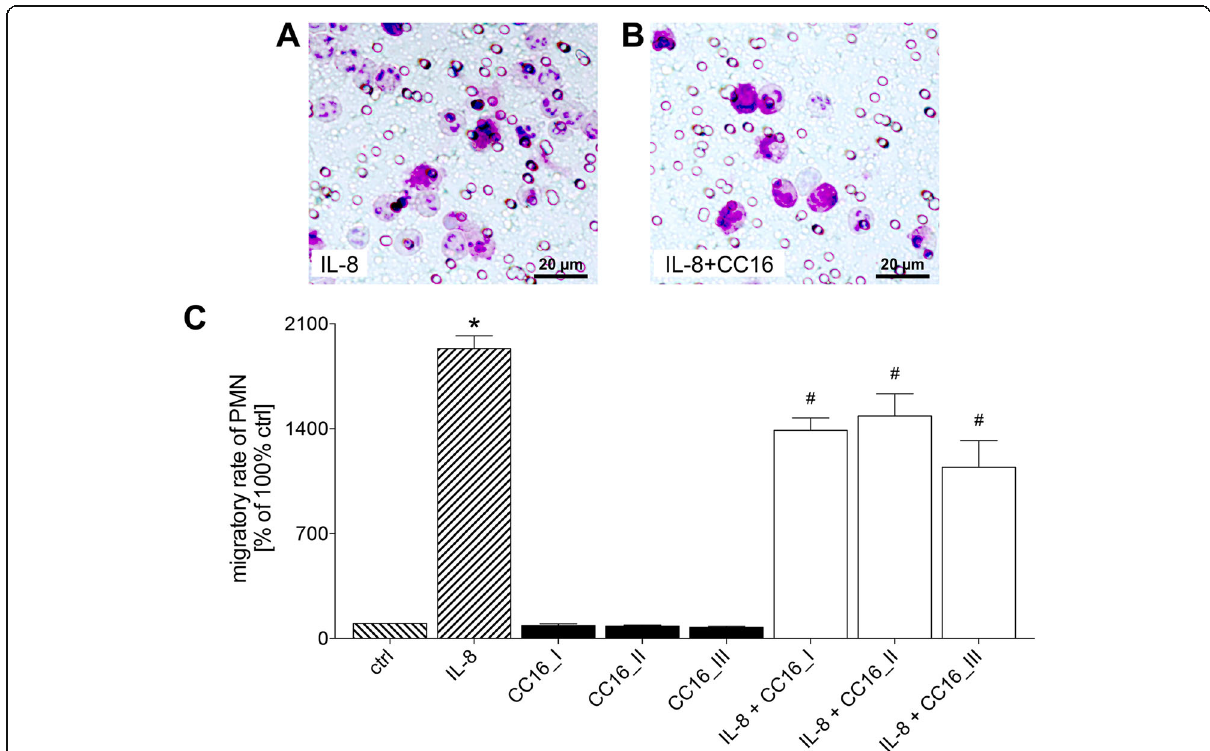
Fig. 1 CC16 reduces PMNL migration towards IL-8. Isolated PMNL that have migrated to the lower side of the membrane. a IL-8 and ( b ) IL-8 concurrent with CC16 as chemoattractants.( c ) Migration capacity of isolated PMN towards different concentrations of CC16 (CC16_I: 100 ng/ml, CC16_II: 33.33ng/ml and CC16_III: 1 ng/ml, respectively). p < 0.05: *: vs. all; #: vs. ctrl, IL-8 and CC16I, II, and